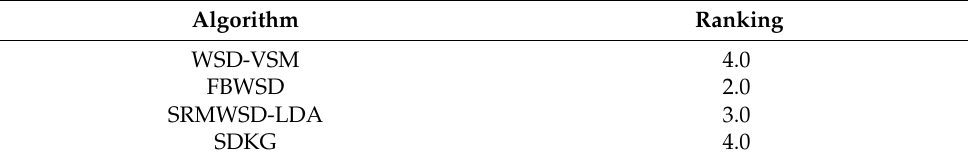
Table 4. Average rankings of the algorithms.